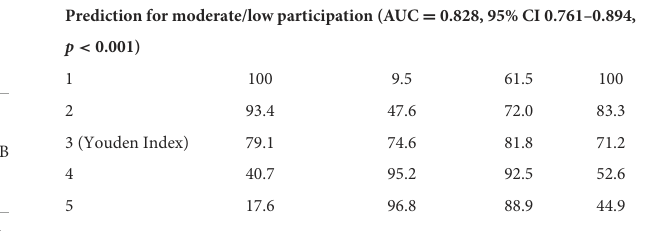
ModelA:Usingthesavedprobabilitiesofthesixintrinsicvariablesonlowparticipation. ModelB:UsingtheoddsratiosofModelAasweightedscores. ModelC:Addingupthenumberofpositiveintrinsicvariables.